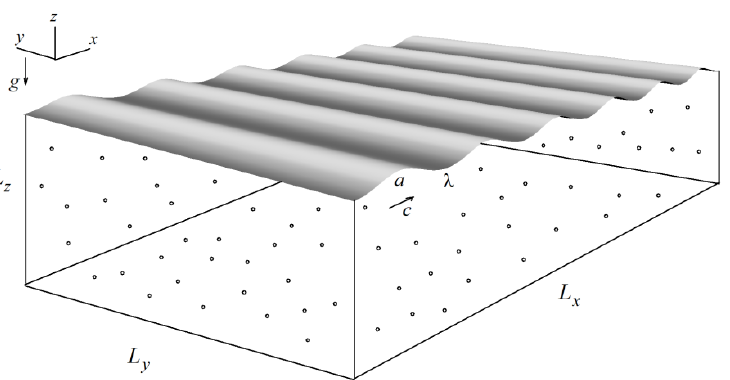
Figure 1. Schematic of the problem: ( x , y , z ) are the Cartesian coordinates; a , λ , c are the surface wave amplitude, length, and celerity; g is the acceleration due to gravity; L x , L y , L z are the domain sizes. Symbols (open circles) show injected bubbles (not to scale). A domain with sizes L x = 6 λ , L y = 4 λ , L z = λ , with periodic side boundaries, a solid bottom and a waved upper boundary, z s ( x , t ) , is considered, and the Cartesian coordinates are employed, 0 ≤ x ≤ L x ; − L y /2 ≤ y ≤ L y /2; − L z ≤ z ≤ z s . The motion of the fluid (water) is driven by the upper boundary where a progressive, two-dimensional (2D) stationary wave of amplitude a , celerity c and length λ propagating in the positive x -direction is